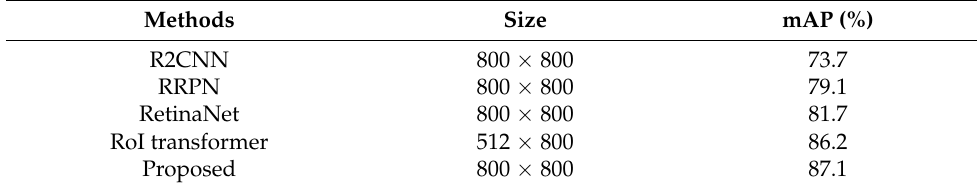
Table 6. Comparisons with different methods on the HRSC2016